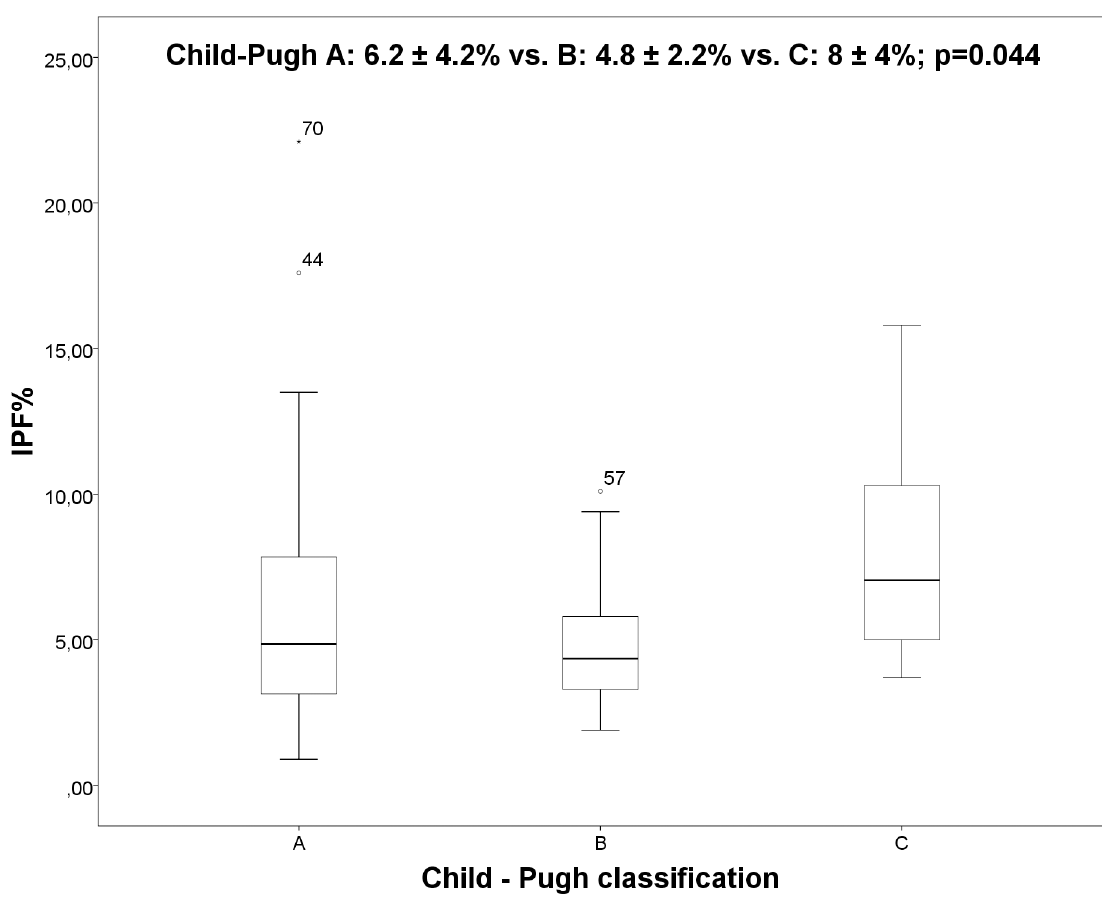
Fig 4. Boxplot: IPF% and Child-Pugh classification.